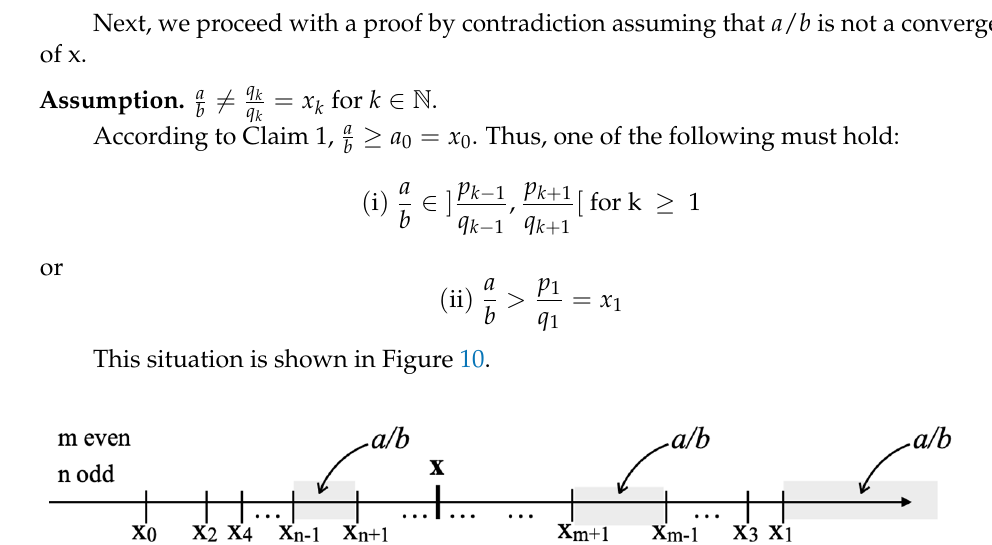
Figure 9. Any best approximation of the second kind is in the grey shaded area, i.e., greater than or equal to the convergent x 0 .